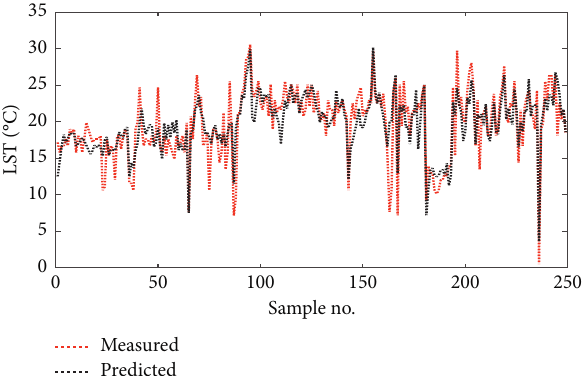
Figure 9: Measurements and WNN prediction for training stage of LST.